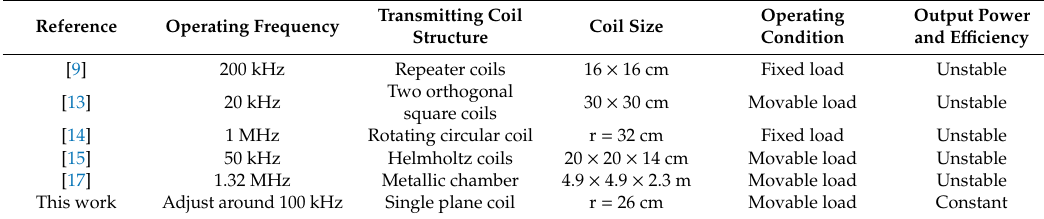
Table 3. Comparison of multi-load WPT